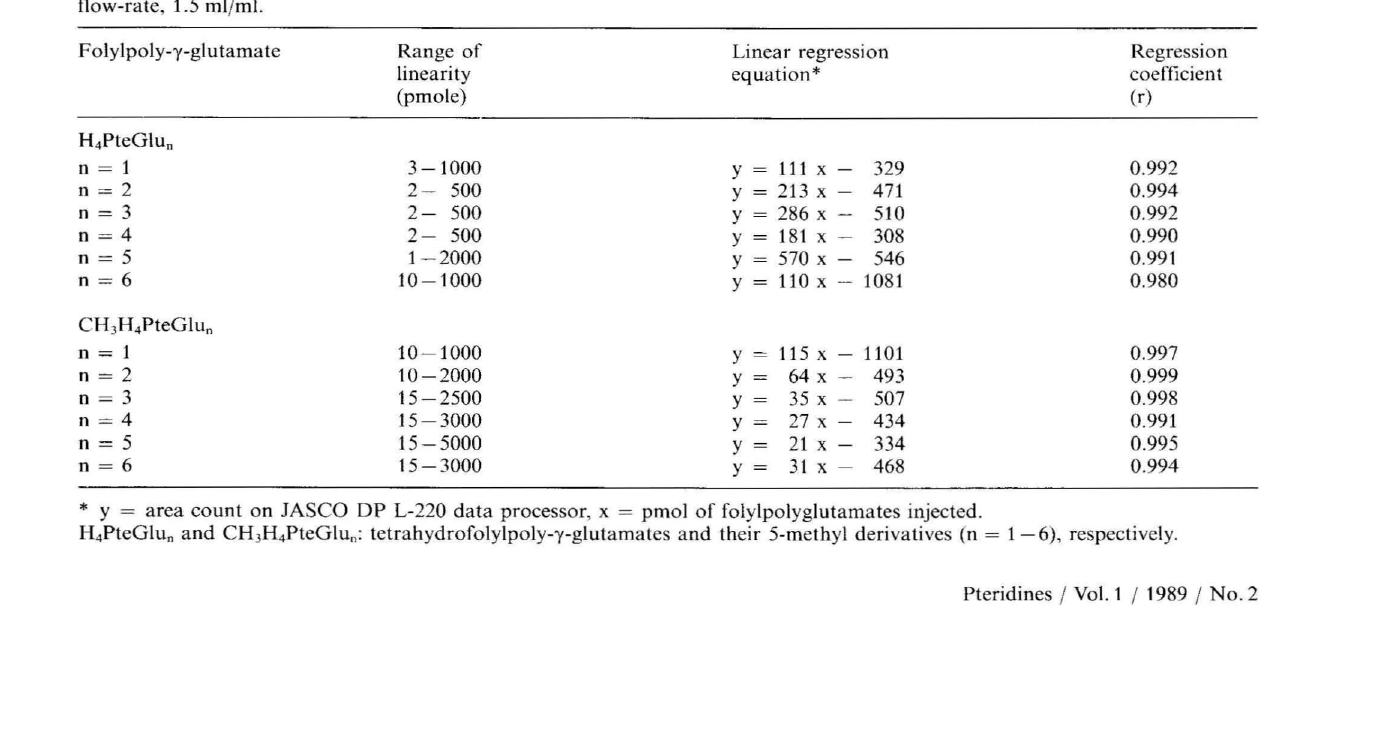
Table 1. Quantitative determination of tetrahydrofolylpoly-y-glutamates using HPLC The quantitative chromatographic parameters were obtained by least squares regression analysis of the peak area determined at + 350 mY versus the amount of each compound injected on a column (50 x 4.6 mm) packed with a Cosmosil 5 Ph. Eluting conditions: mobile phase, 50 mM potassium dihydrogen phosphate, pH 2.2, containing 50 11M disodium EDTA and 1 % methanol; flow-rate, 1.5 ml/m!. Linear regression Regression